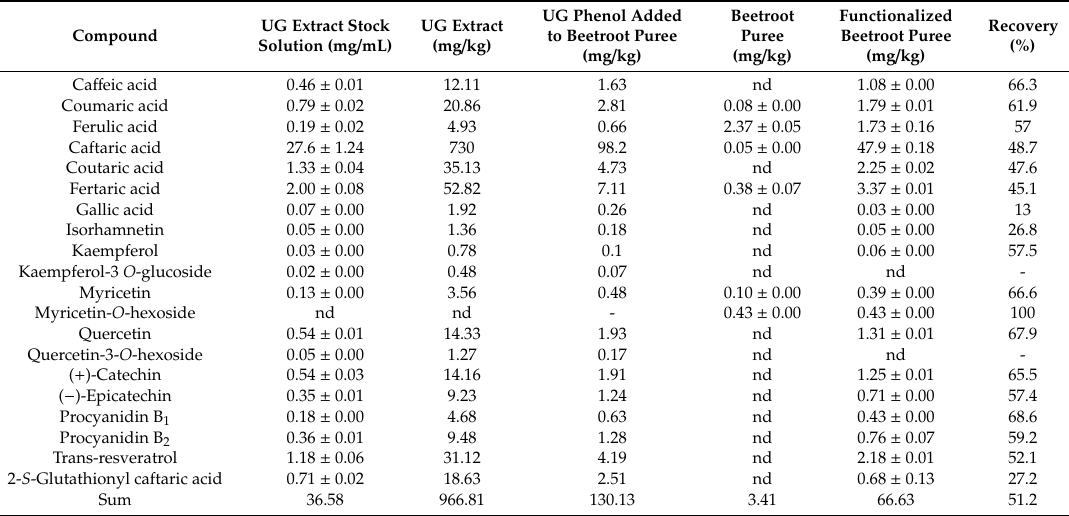
Table 2. Phenol composition of the UG extract stock solution (6.81 g / L of phenols), UG extract (powder), beetroot puree, and beetroot puree functionalized with 1.93 g / kg of phenols from the UG extract. UG Extract Stock Compound Solution (mg /